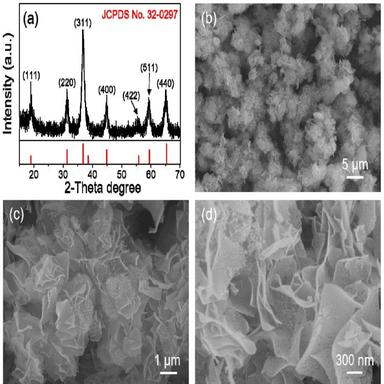
(a) XRD pattern and (b-d) SEM images of MnCo2O4.5 nanosheets.